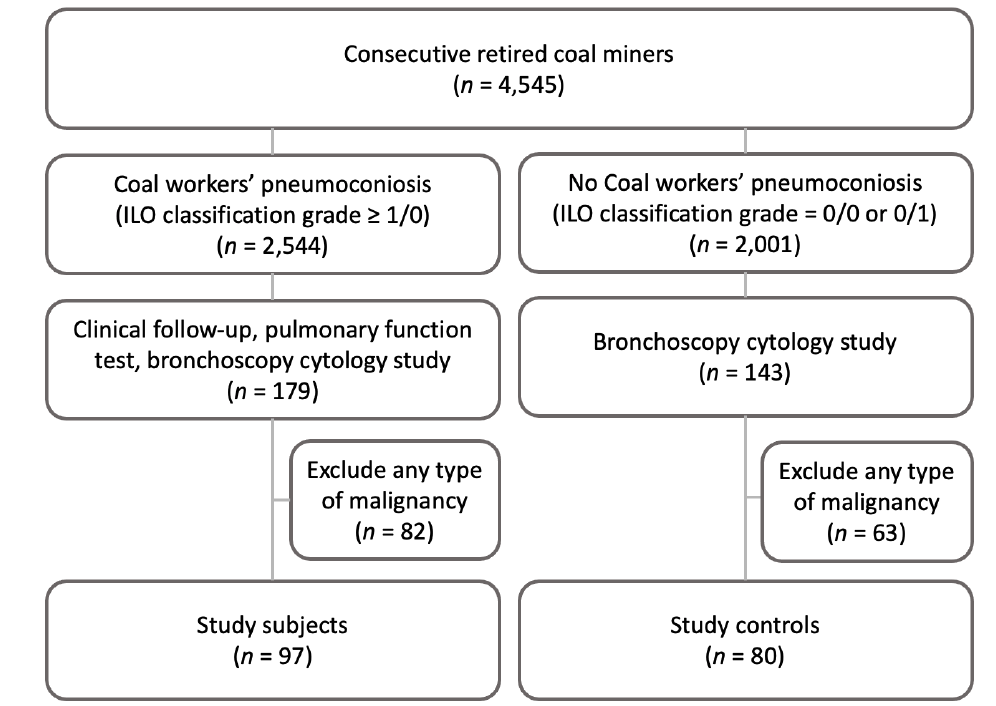
Figure 1. Schematic overview of the study